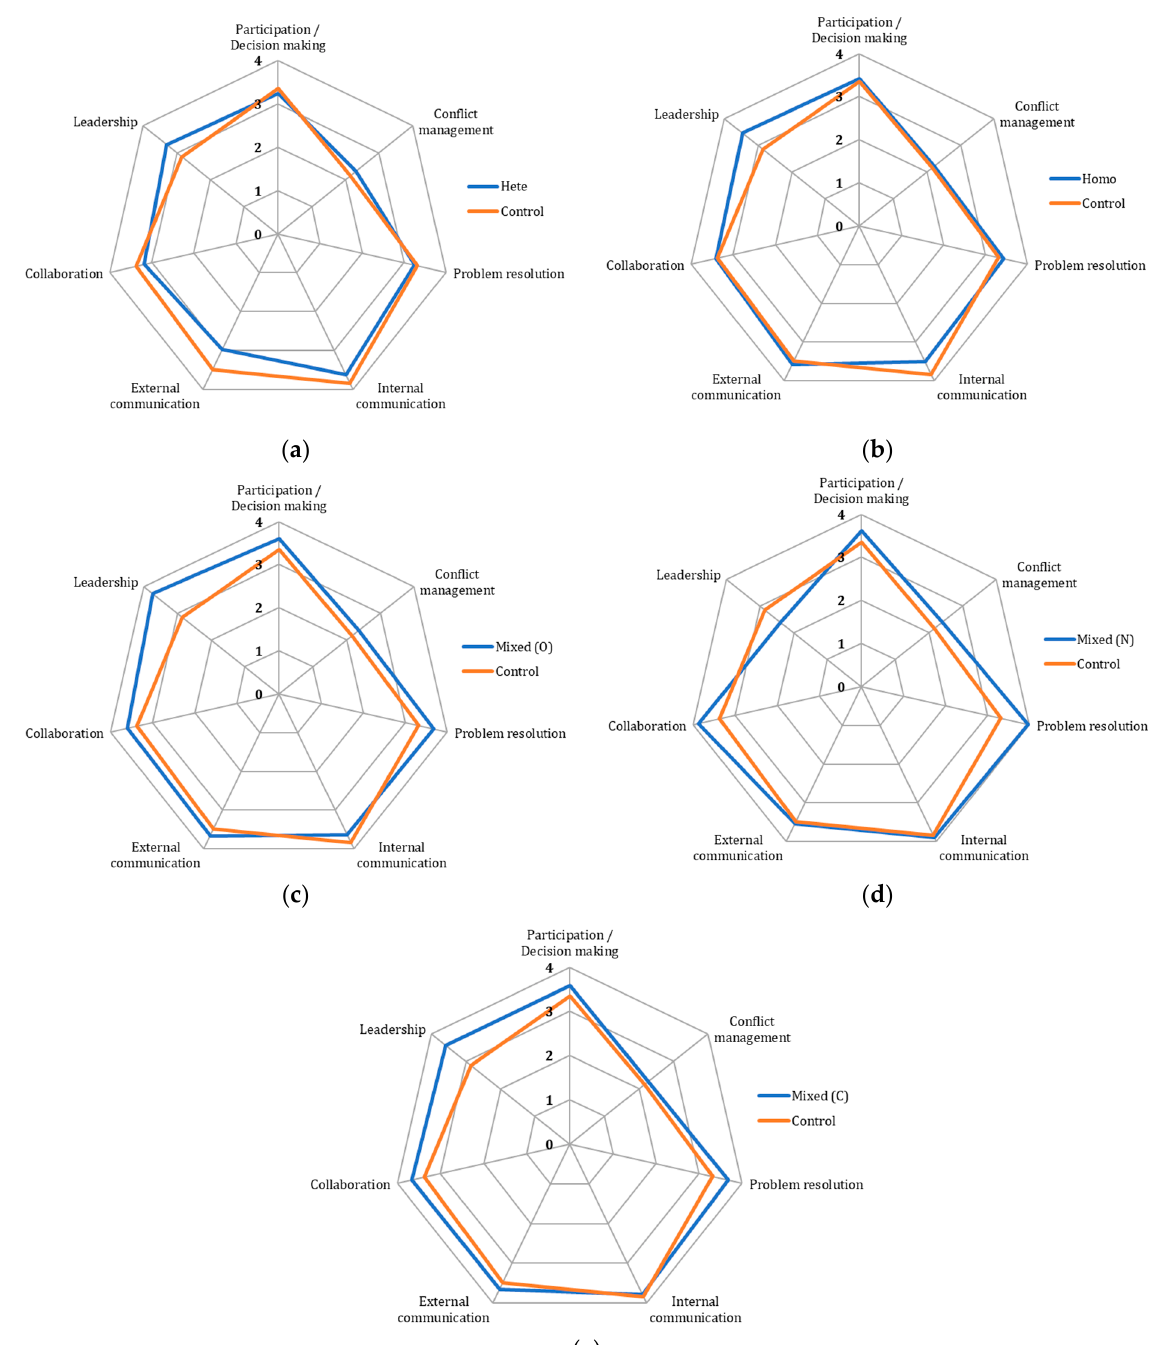
Figure 9. Traces of experimental groups versus control groups. ( a ) Heterogeneous formation; ( b ) homogeneous formation; ( c ) mixed (O) formation; ( d ) mixed (N) formation; ( e ) mixed (C) formation.